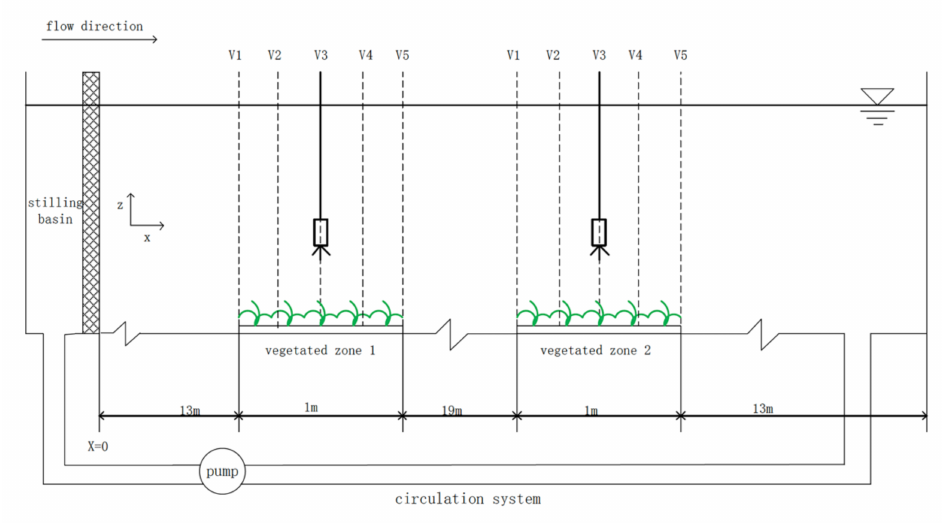
Figure 1. Experimental setup: schematic of the flume (long view, not to